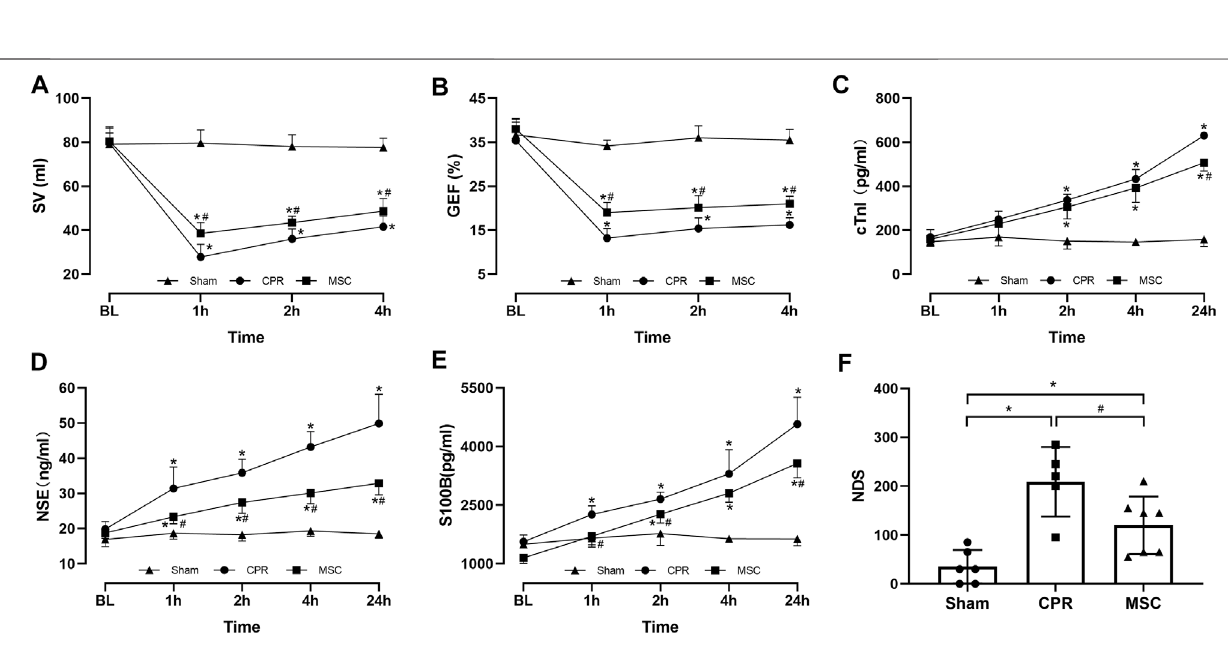
FIGURE 3 | Cardiac, cerebral function and injury biomarkers (A) Stroke volume (SV) (B) Global ejection fraction (GEF) (C) Cardiac troponin I (cTnI) (D Neuron speci fi cenolase(NSE) (E) S100Bprotein(S100B) (F) Neurologicalde fi citscore(NDS).BL,baseline;CPR,cardiopulmonaryresuscitation;MSC,mesenchymalstemcell. * p < 0.05 versus sham group; # p < 0.05 versus CPR